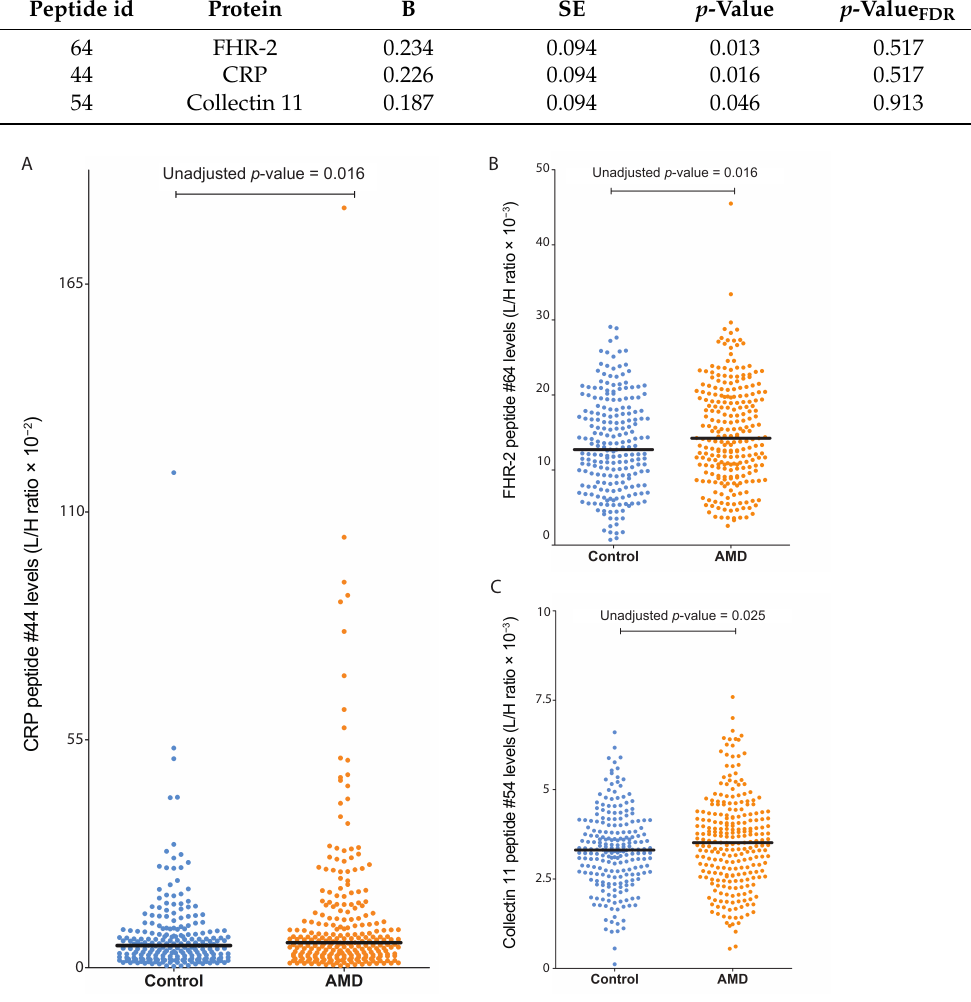
Table 2. Suggestive associations of complement peptide levels with age-related macular degeneration. Beta values show the effect estimates from the regression analysis results. AMD status was the dependent variable in the regression model, while peptide levels, age, sex, BMI, smoking status and triglyceride levels were added as independent variables.